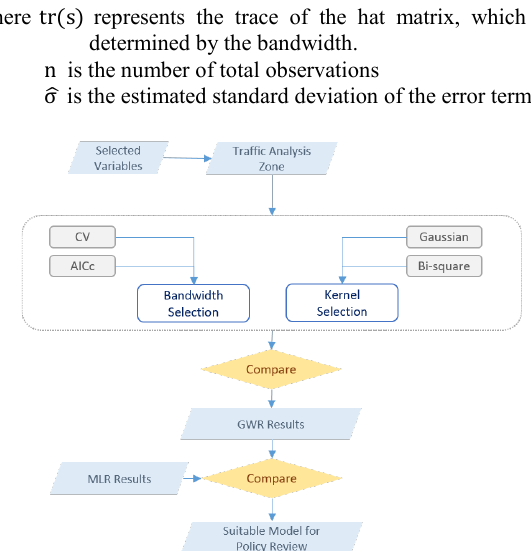
Figure 2. Overall workflow of GWR